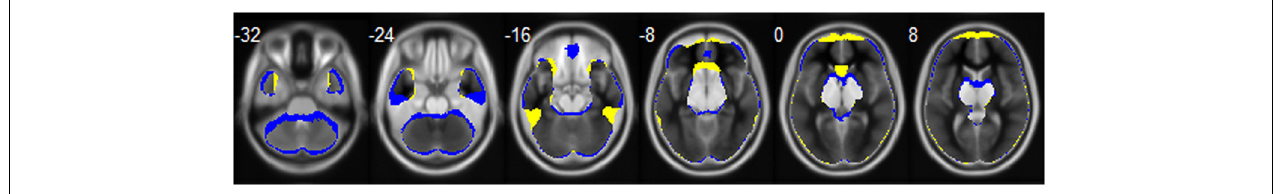
FIGURE 1 | The mean whole brain mask calculated based on the functional images of all the participants for the AP (colored in blue) and PA (colored in yellow) PE direction, respectively. Brain regions that the two directions overlapped are displayed in gray.